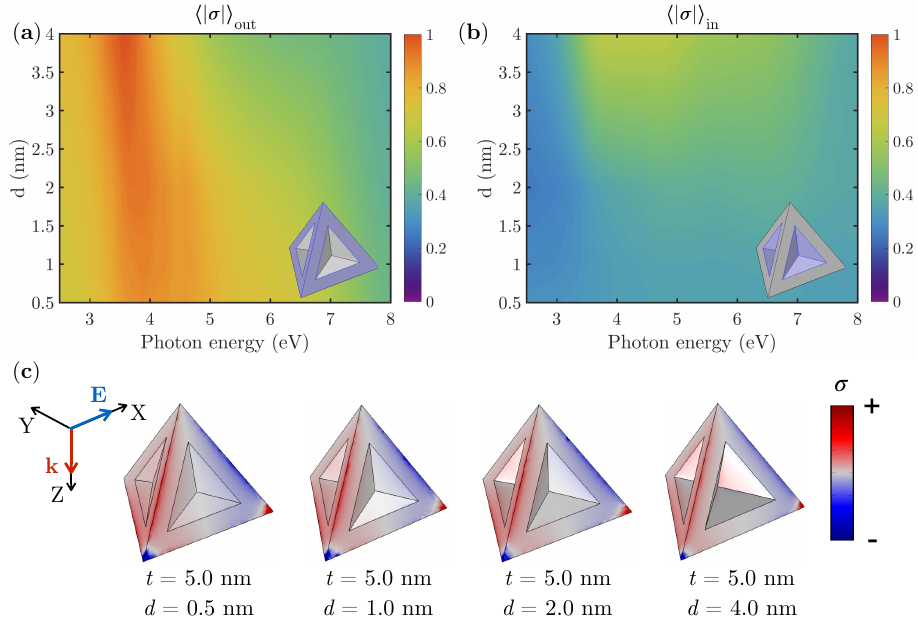
2 ) averaged E | | 2 ) over the surface of the E | | 2 ) over the surface of the E | |